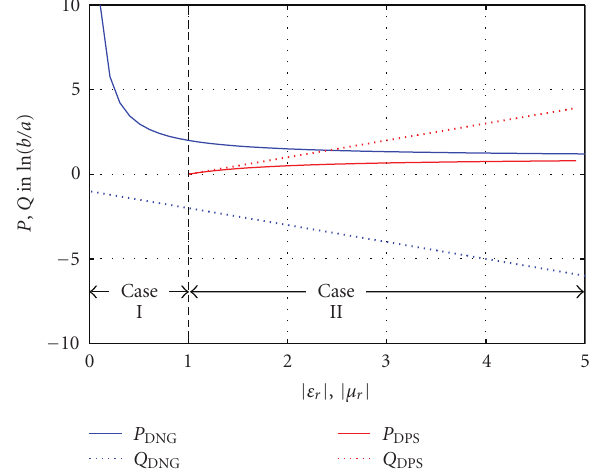
Figure 2: E ff ect of ε r and μ and DNG